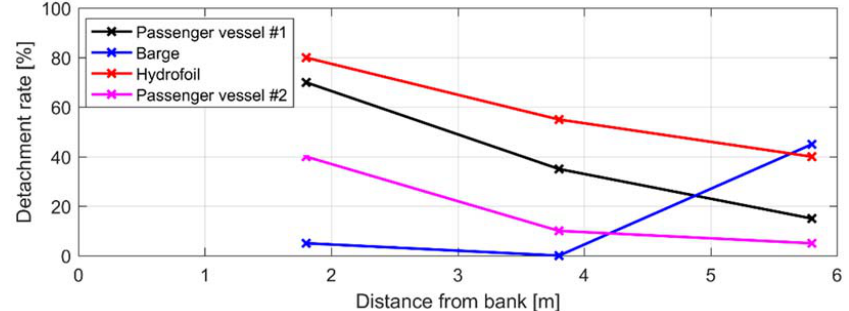
Figure 11. Estimated detachment rates in different distances from the bank, for different ships.